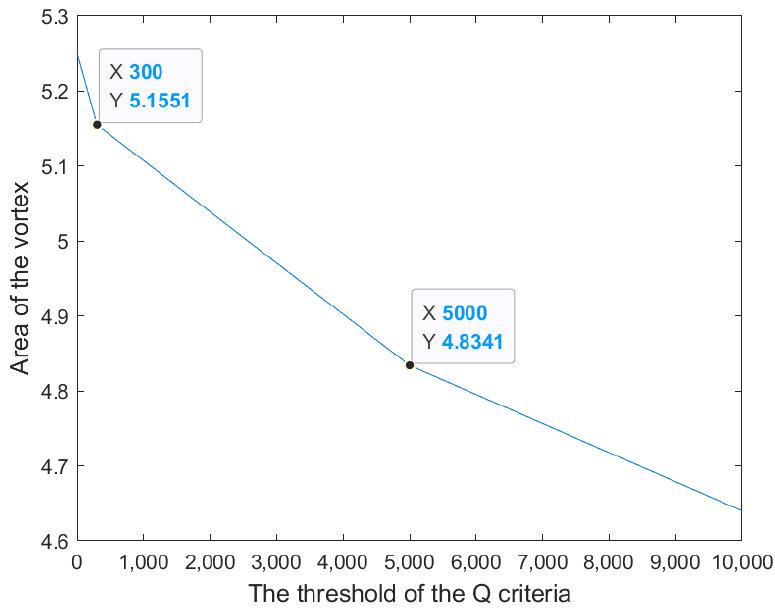
Figure 13. The vortex area under different thresholds varied with the thresholds.